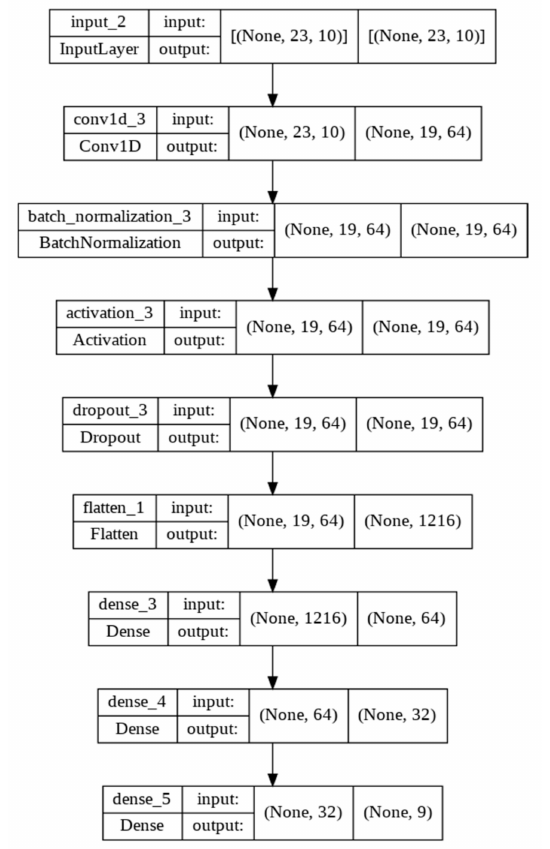
Figure A2. Temporal